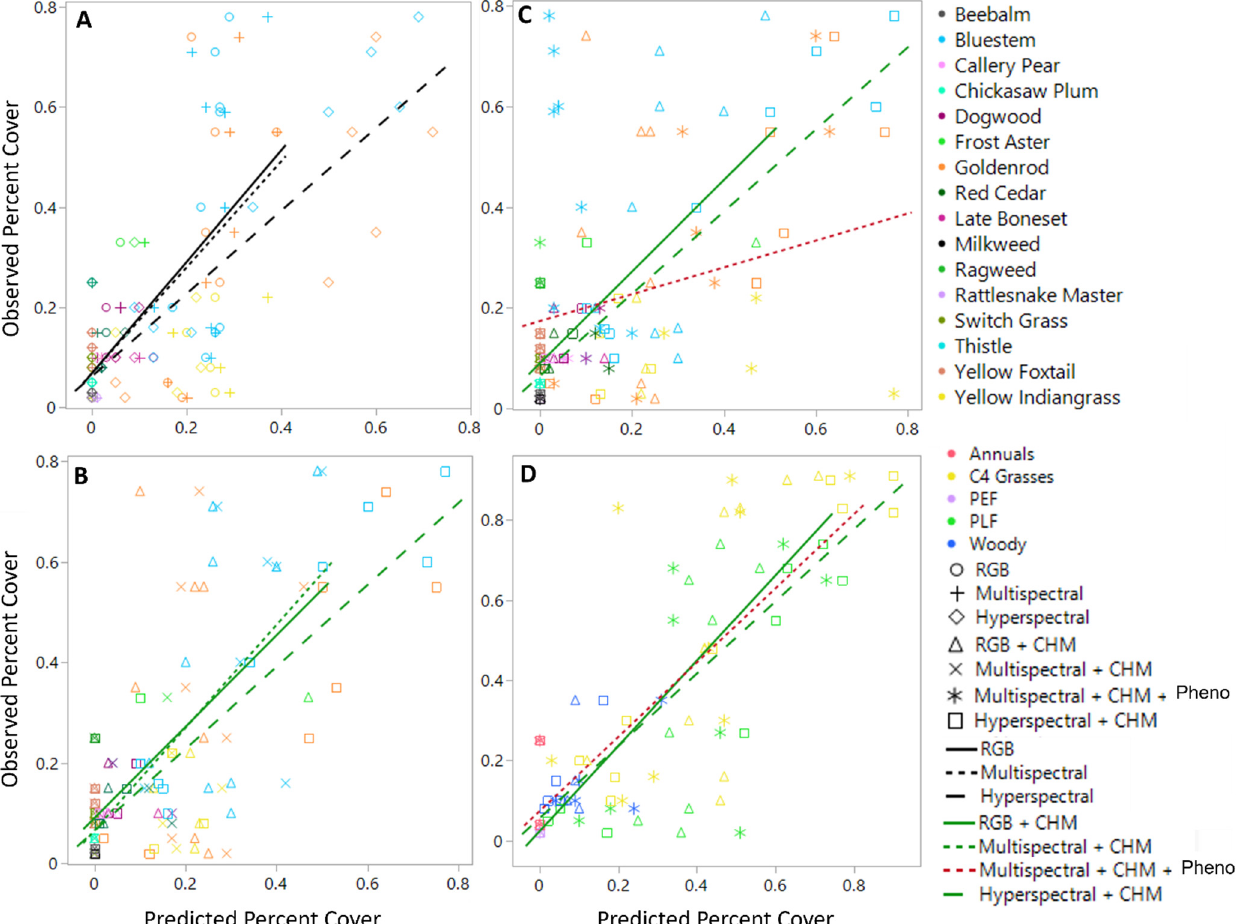
Figure 9. Observed vs. predicted percent cover estimates for plant species (panels ( A – C )) and plant functional types (panel ( D )). Random forest classification performance was compared among sensors (Hyperspectral, Multispectral, RGB) without CHM data fusion (panel ( A )), with CHM data fusion (panel ( B )), overall top-performing species models (panel ( C )), and overall top-performing PFT models (panel ( D )). Symbols refer to sensor product and color refers to species or